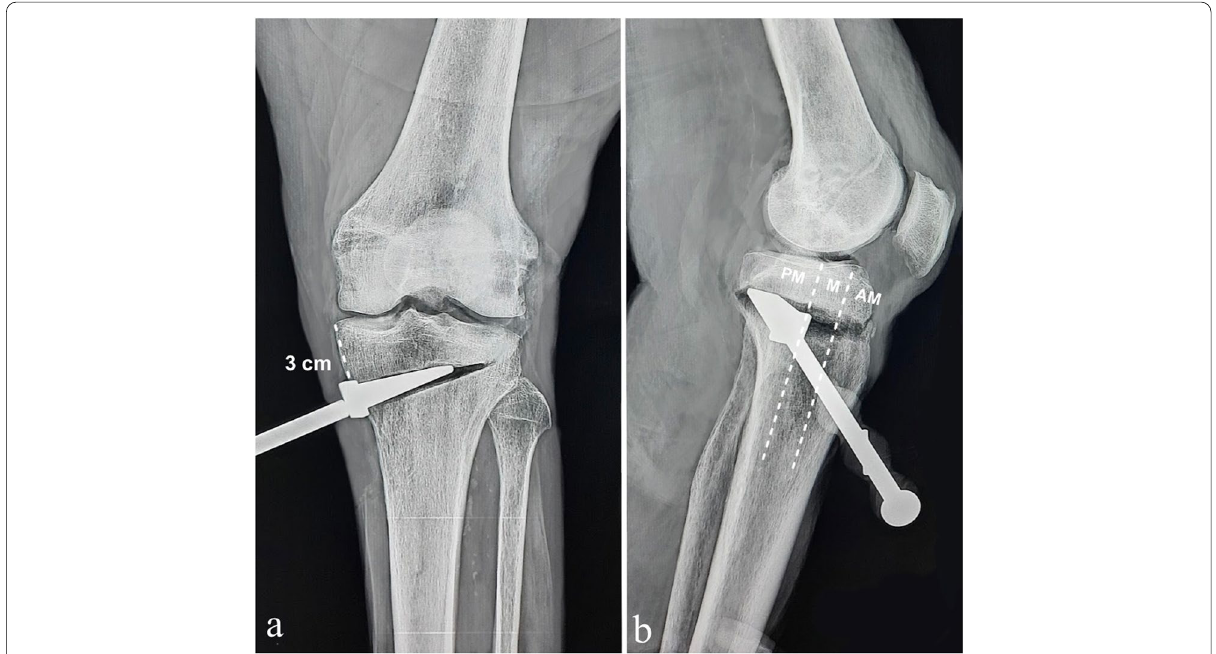
Fig. 4 Radiographic control in a left knee, 3 cm case. Anteroposterior view ( a ) and lateral knee projection ( b ) with an opening wedge in the PM third location. AM, anteromedial; M, medial; PM, posteromedial